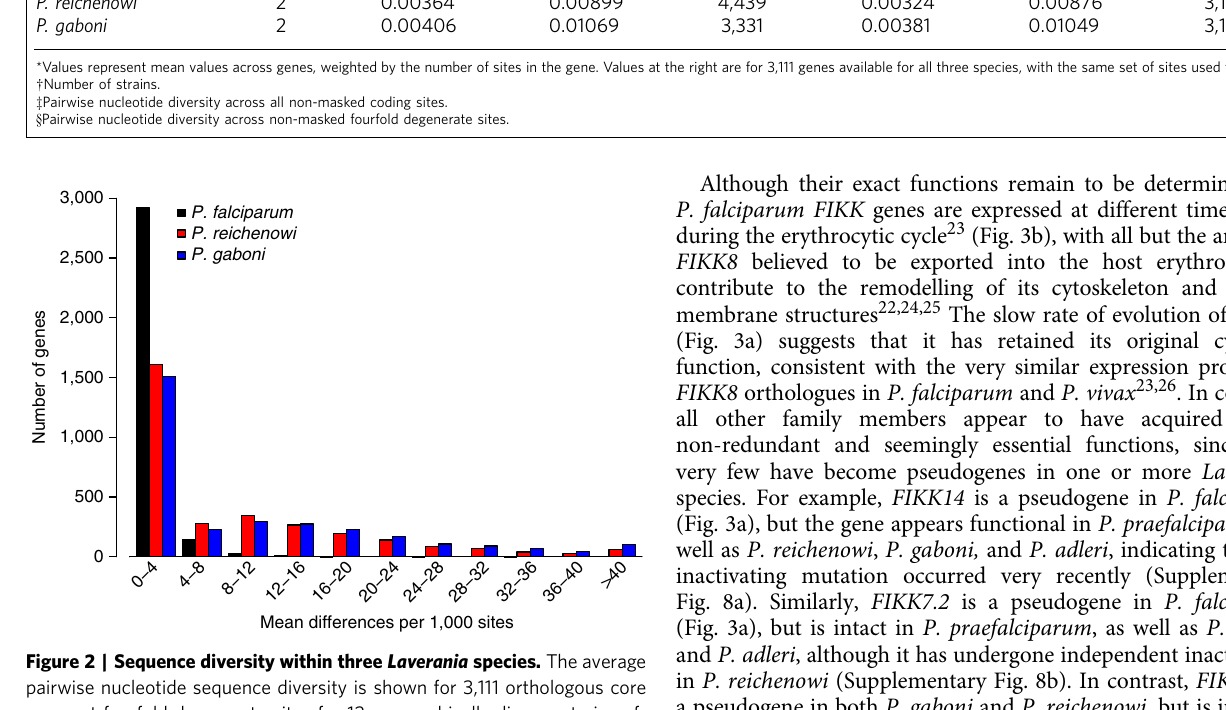
Table 3 | Nucleotide diversity within Laverania species. Species*